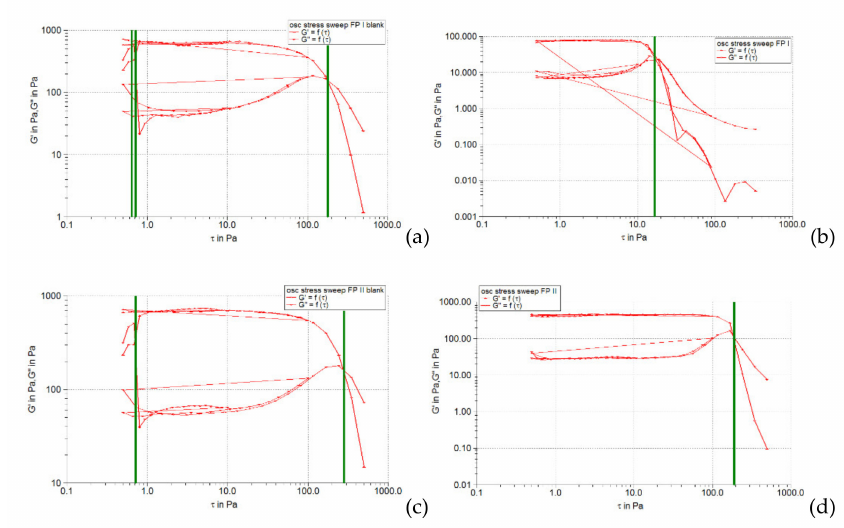
Figure 2. The behavior of viscoelastic modules G’ and G” depending on the shear stress for hydrogels based on Carbopol 940 and propylene glycol, simple or loaded with caffeic acid liposomes: ( a ) FPI blank, ( b ) FPI, ( c ) FPII blank, ( d ) FPII.